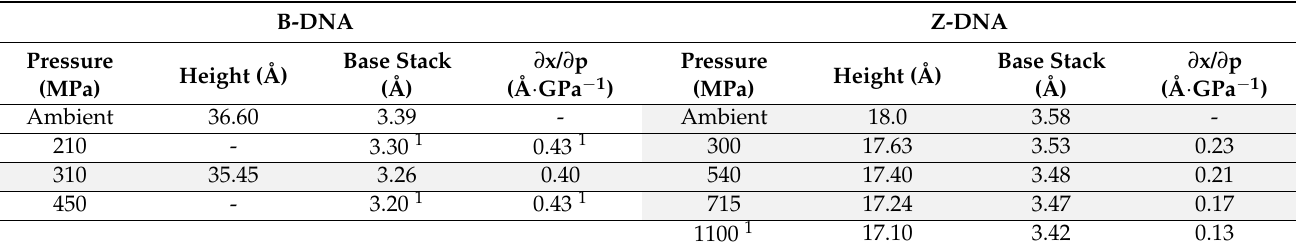
Table 6. Pressure dependencies of the longitudinal compression distances and base stackings. The ∂ x/ ∂ p parameters were estimated as linear within each bin of pressure. Grey lines correspond to structures fully determined. The ∂ x/ ∂ p term is given in the direction of compression